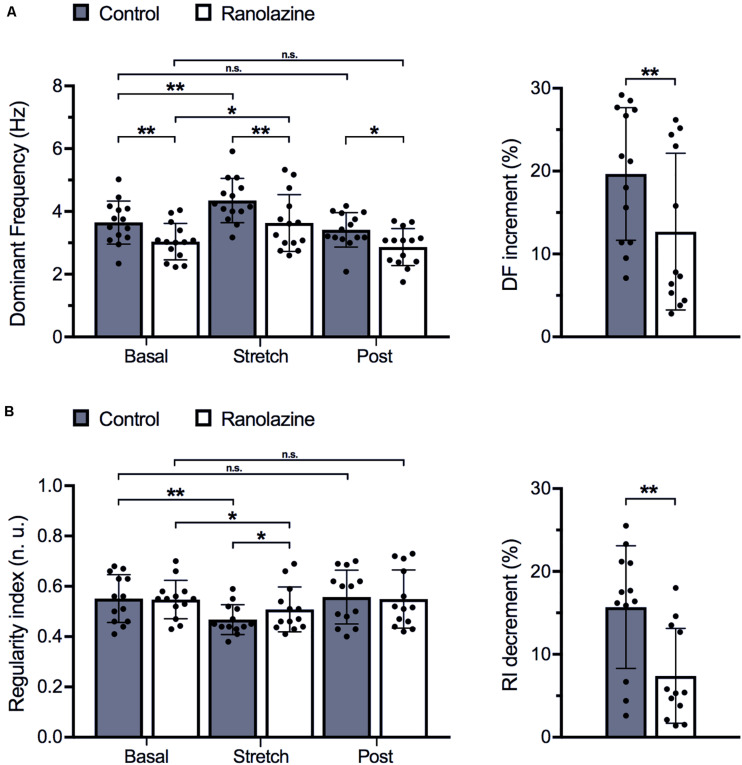
Effects of ranolazine on stretch-induced modifications of spectral characteristics of fibrillatory activity (mean ± standard deviation) (n = 14). (A) Dominant frequency under control and ranolazine conditions, for basal, stretch (3rd minute), and post-stretch (3rd minute) situations (left) and stretch-induced variation in dominant frequency under control conditions and under ranolazine action (right). (B) Regularity index under control and ranolazine conditions, for basal, stretch, and post-stretch situations (left) and stretch-induced variation in regularity index under control conditions and under ranolazine action (right). *p < 0.05, **p < 0.01, n.s. non-significance.